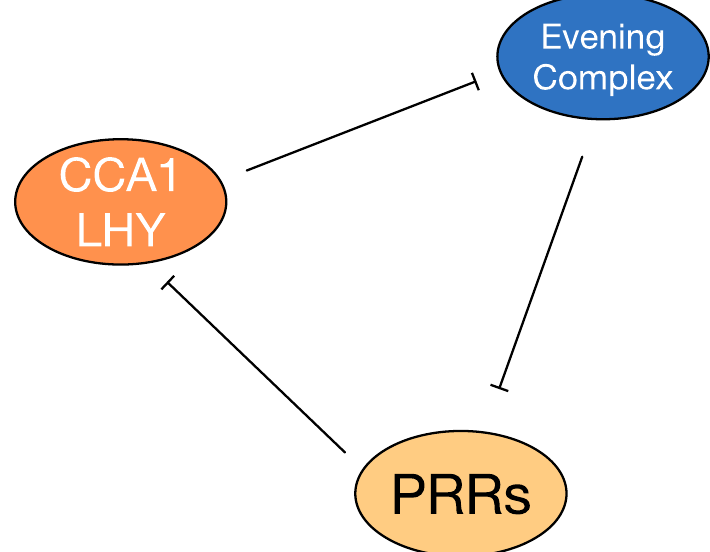
Figure 2. An oversimplified model of the Arabidopsis circadian system. CCA1 / LHY are induced at dawn and repress expression of the Evening Complex, which represses itself while also repressing expression of PRR genes. Accumulation of PSEUDO-RESPONSE REGULATORs (PRRs that are distinct from Pattern Recognition Receptors) represses numerous genes, including CCA1 and LHY . More detailed descriptions of the circadian system are detailed elsewhere